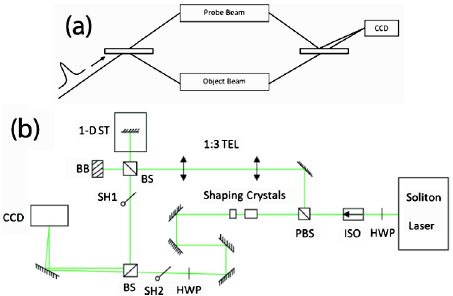
FIG. 1. (a) Conceptual and (b) schematic implementation of the diagnostic. (a) The initial beam is split to the probe beam and object beam, with adjustable time delays, then they are com- bined with a small angle on the CCD camera. (b) The experi- mental setup to measure stacked soliton pulses: ISO, isolator; HWP, half wave plate; PBS, polarization beam splitter; TEL, telescope; BS, beam splitter; BB, beam block; 1D ST, motorized one-dimensional stage; SH1, shutter 1; SH2, shutter 2; CCD, CCD